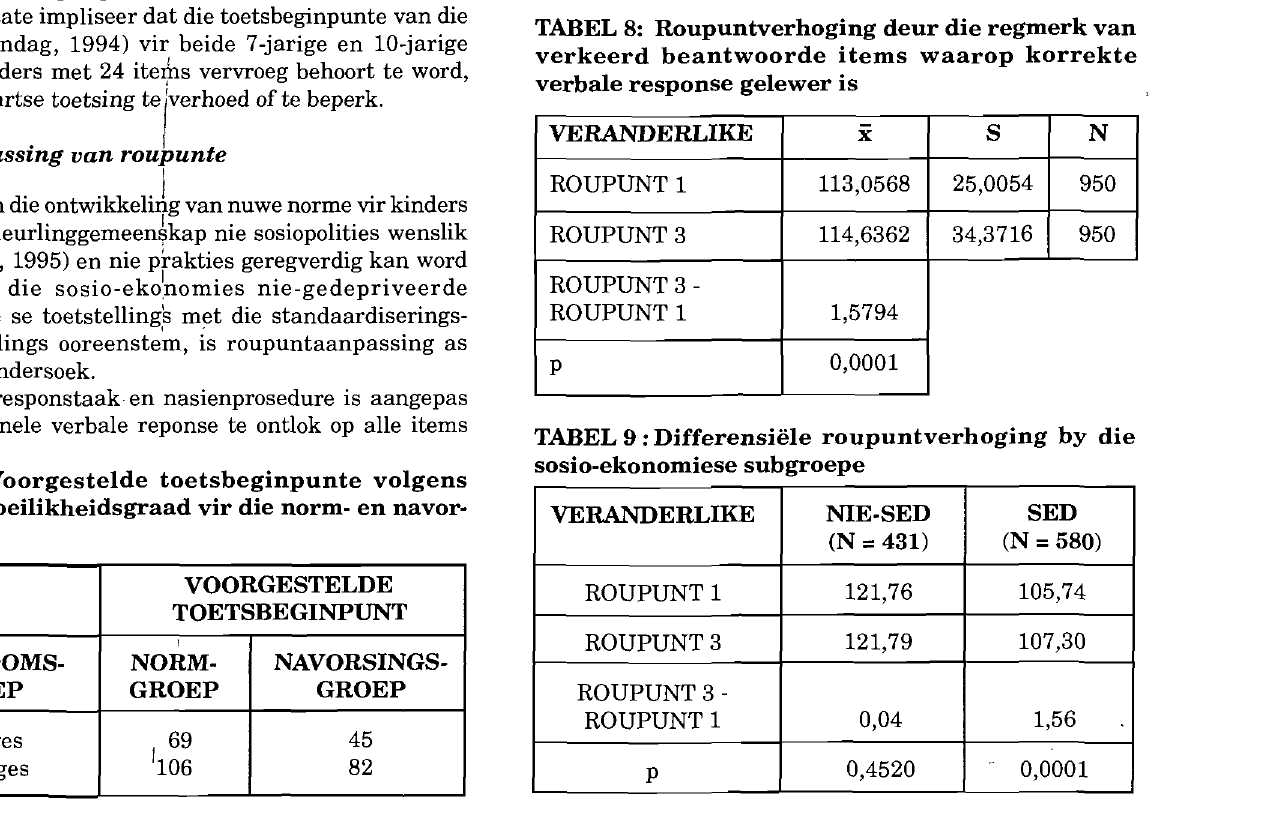
TABEL 9 : Differensiele roupuntverhoging by die sosio-ekonomiese